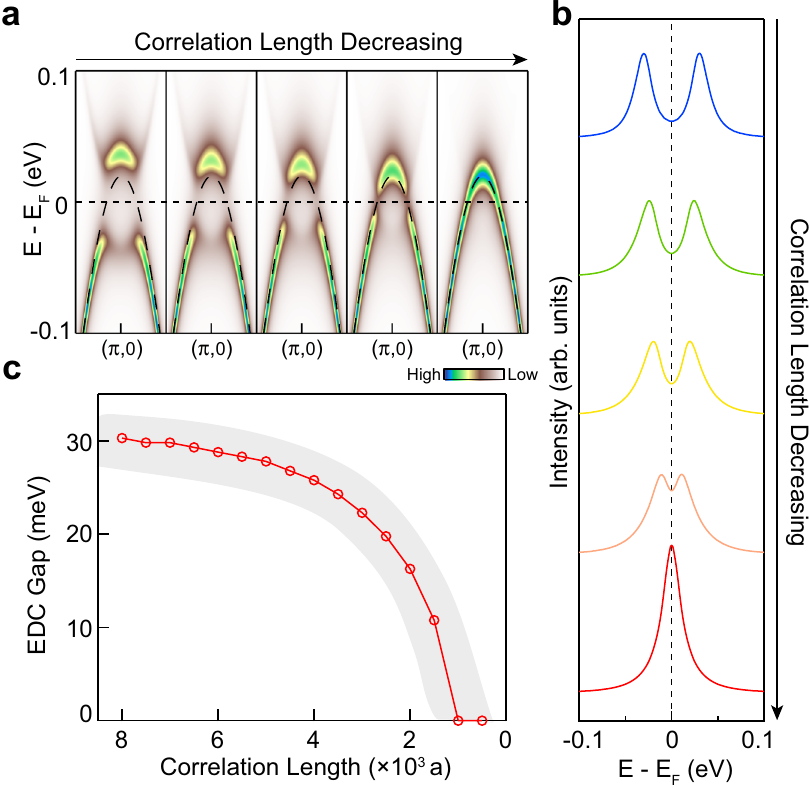
Fig. 4 Simulation of preformed Cooper pairs as a function of the correlation length. a Simulated spectra with selected correlation lengths ( ξ = 8000, 3500, 2500, 1500 and 500 lattice parameter). The dashed black curves represent the bare band in the simulations. b EDC at the Fermi momentum, as a function of correlation length. c Gap magnitude as a function of correlation length, extracted from the simulated EDC at the Fermi momentum. Note that the absolute value of the correlation length in the simpli fi ed model cannot be directly compared with that in the real material, see Supplementary Methods for